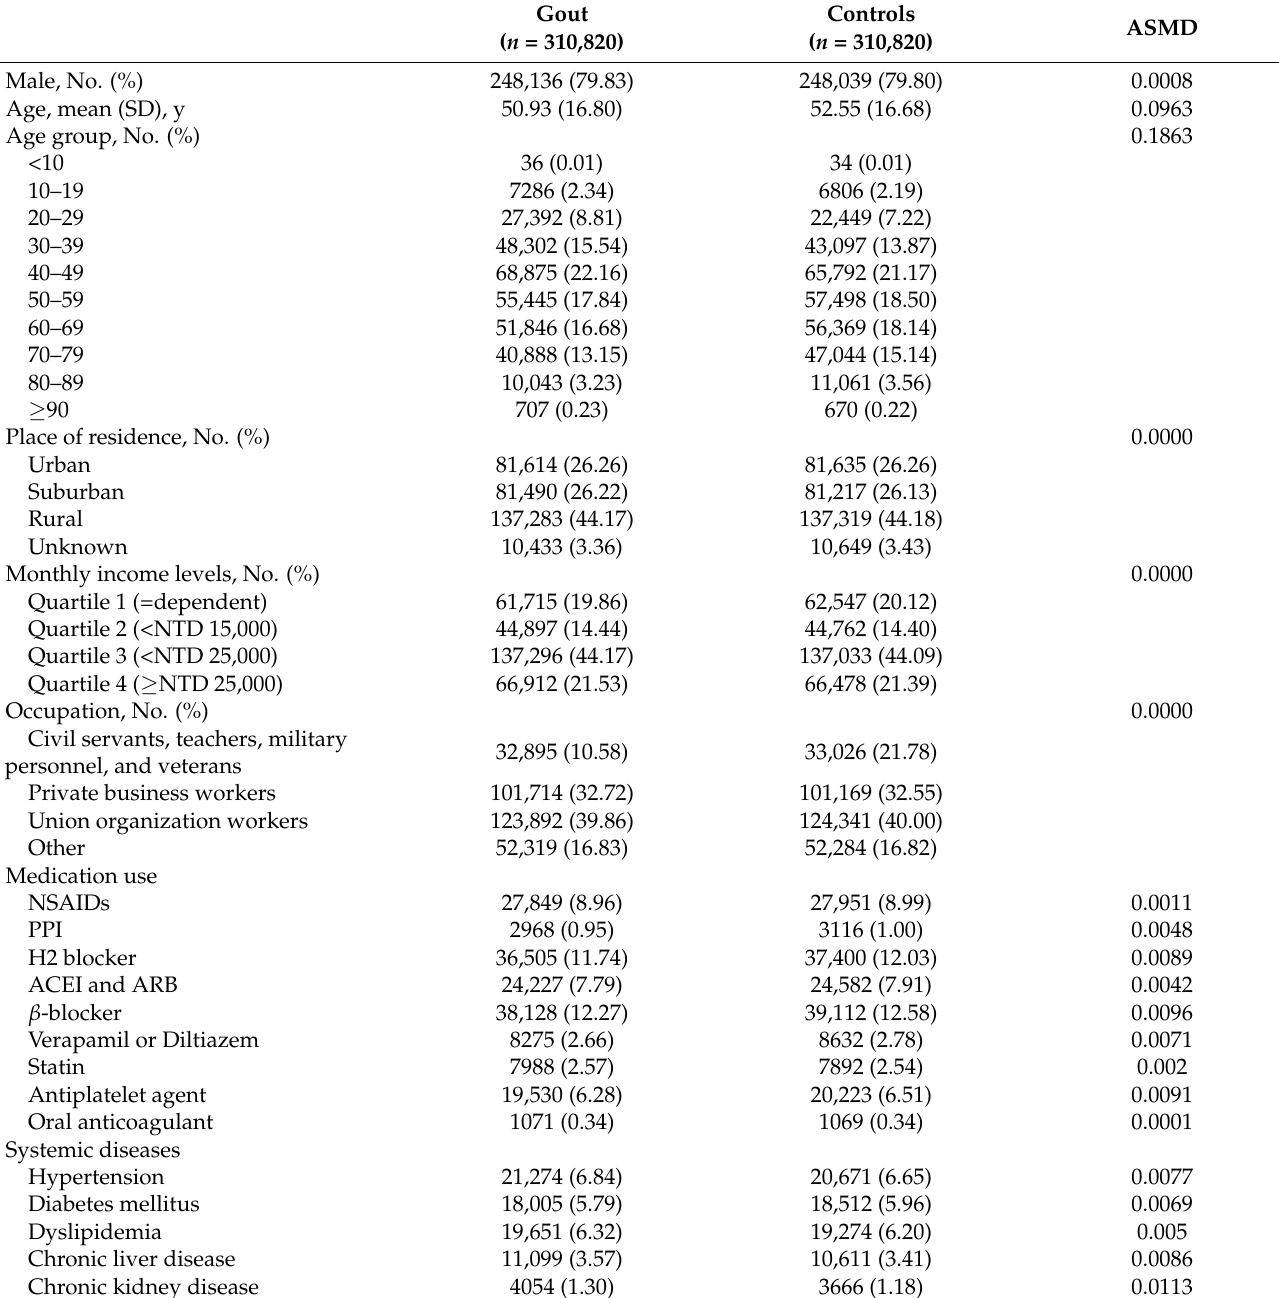
Table 1. Demographic and clinical characteristics of gout and non-gout control cohorts in Taiwan, 2000 to